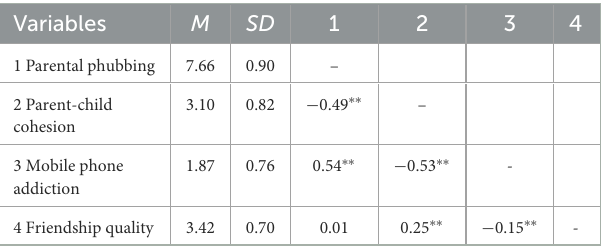
TABLE 2 Descriptive statistics and correlations between main variables.